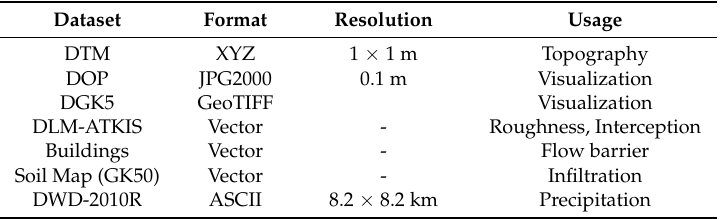
Table 1. Used Datasets for the Risk